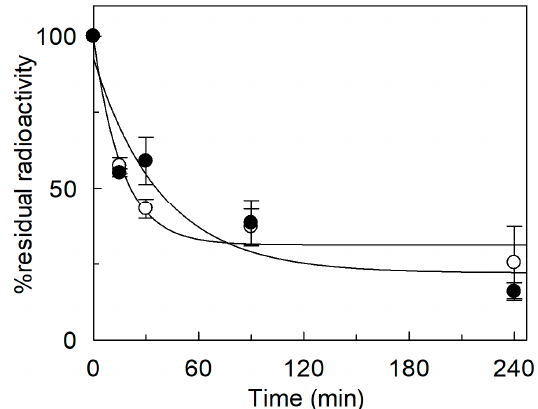
Figure 9. Efflux from proteoliposomes reconstituted with Sl CAT2. Sl CAT2 was purified and reconstituted in proteoliposomes as described in Section 4.4. Arginine efflux was measured at the indicated time, as described in Section 4.5. Internal residual radioactivity was measured as percent with respect to control (time 0), in the absence (open circle) or in the presence (closed circle) of 0.45 mM Mg 2+ in the extraliposomal compartment. Data are plotted using the single exponential equation with offset as described in Section 4.5. Results are the means ± SD from three experiments.